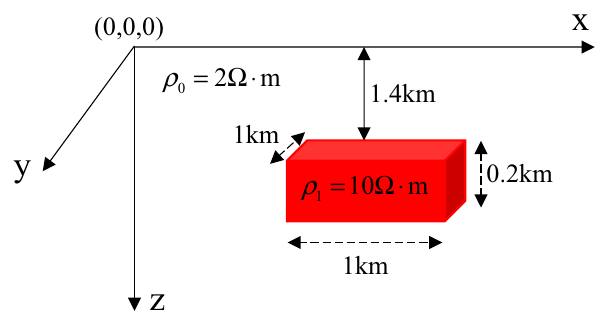
Fig. 4 Three-dimensional model set up in reference to the logging data